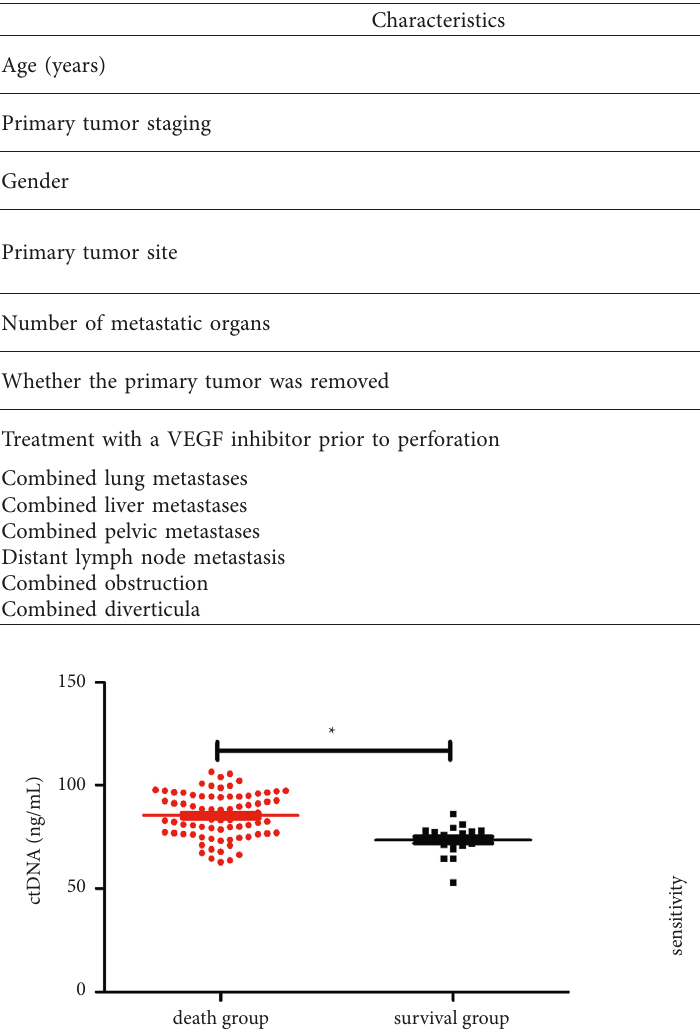
Figure 1: Comparison of ctDNA expression between the death group and the survival group. Two groups were compared, ∗ P < 0 . 05.